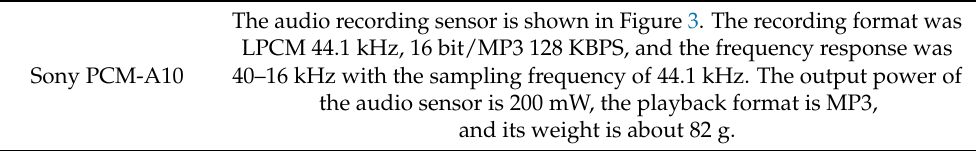
Table 2. The introduction of the audio sensor and the computer used.